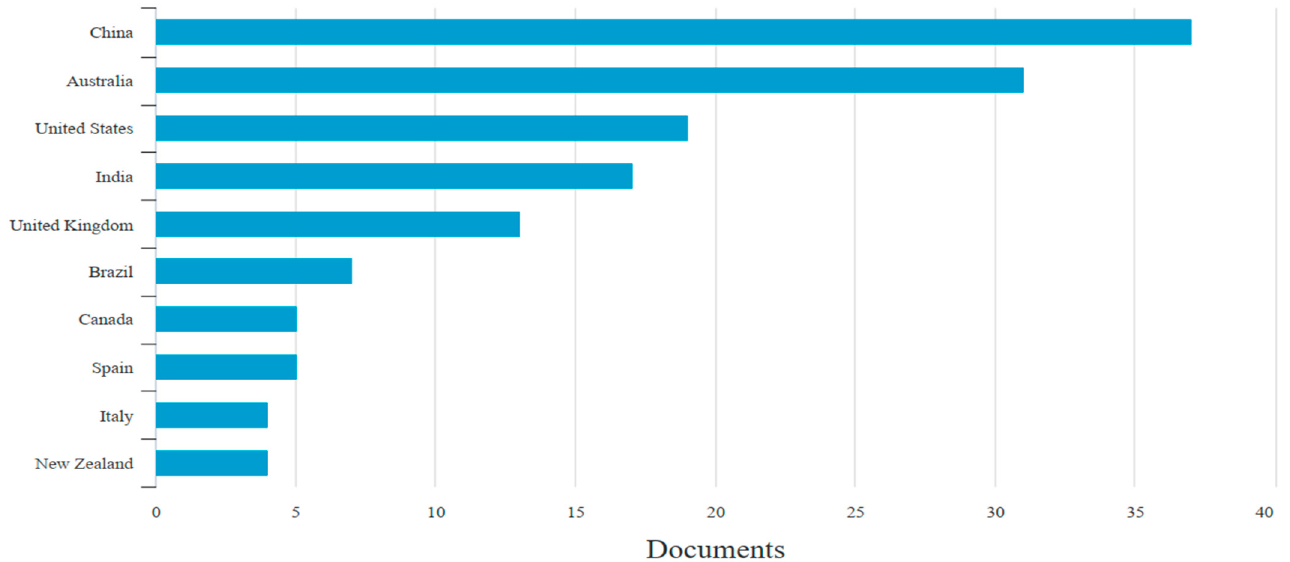
Figure 2. TOP 10 countries represented by scientific publications on soil amelioration. Source: authors’ compilation based on the Scopus database.